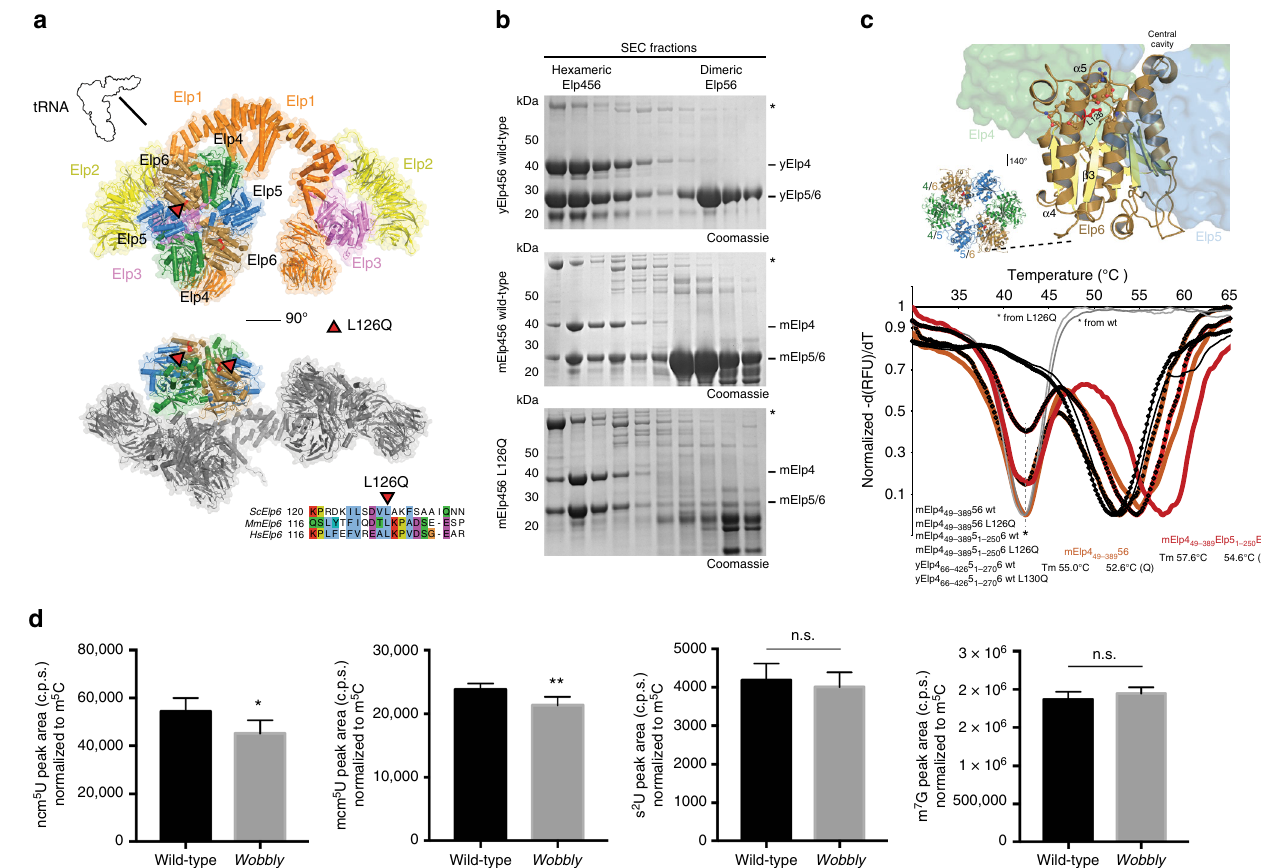
Fig. 4 Elp6L126Q destabilizes Elp456. a Structural overview of the Elongator complex in cartoon representation showing individual subunits (Elp1 (orange), Elp2 (yellow), Elp3 (pink), Elp4 (green), Elp5 (blue), and Elp6 (brown)) from two perspectives. The Elp6L126Q mutation is highlighted in red (triangles). Multiple sequence alignment of Elp6 proteins from S. cerevisiae (Q04868), M. musculus (Q8BK75), and H. sapiens (AAH00623) highlighting the mutated region (bottom). b SDS-PAGE analyses after size exclusion chromatography (SEC) of puri fi ed Elp456 complexes from yeast (top), mouse wild- type (middle) and mouse Elp6L126Q (bottom). Subunits are labeled on the right and co-migrating chaperone is indicated by an asterisk. c same as ( a ) highlighting the localization of the hexameric Elp456 ring and the mutation (top). Normalized fi rst derivative curves from Thermo fl uor analyses of puri fi ed yElp4 66-426 5 1-270 6 (black), mElp4 49-389 56 (orange), and mElp4 49-389 5 1-250 6 (red) complexes. Wild-type complexes are shown by lines, mutations (L126Q for mouse and L130Q for yeast) are labeled with black circles, copuri fi ed contaminations are shown in gray. Calculated melting temperatures are indicated. d Quanti fi cation of ncm 5 U, mcm 5 U, s 2 U, and m 7 G nucleosides in cerebellar lysates from wobbly and wild-type animals analyzed using HPLC/MS ( n = 5 animals per genotype). Presence of ncm 5 U and mcm 5 U tRNA modi fi cations is Elongator-dependent, whilst s 2 U and m 7 G are used here as an example of Elongator-independent tRNA modi fi cations. Statistical evaluation: two-tailed t test. Statistically signi fi cant differences are indicated ( * P ≤ 0.05; ** P ≤ 0.01). Data represent mean ±